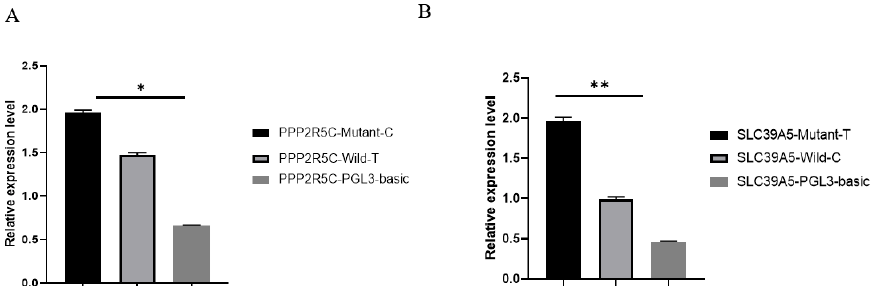
Figure 3. Effect of polymorphisms on the promoter activity of PPP2R5C and SLC39A5. ( A ) The tran- scriptional activity of the PPP2R5C promoter region with different haplotypes; ( B ) the transcriptional activity of the SLC39A5 promoter region with different haplotypes. Data are expressed as the mean ± SD. * p < 0.05; ** p < 0.01.